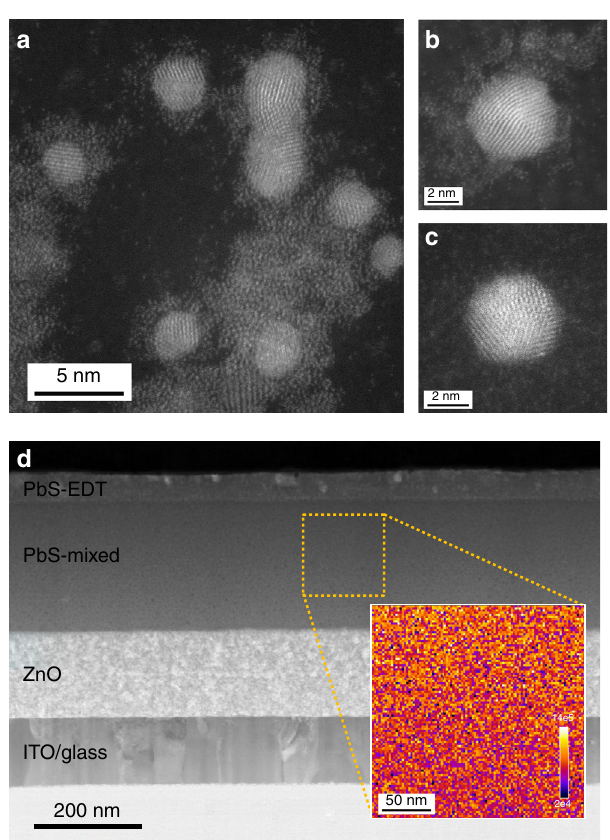
Fig. 4 Electron microscopy analysis of mixed-quantum-dot solid and device. a STEM-HAADF image of freshly drop-cast mixed-QD ink on an ultrathin graphite-based TEM grid (sample was not annealed). QDs with amorphous MAPbI 3 shell ( b ) and without surface shelling ( c ). d Cross-section STEM image of FIB-processed mixed QD-based photovoltaic device. Inset: EELS mapping of iodine in the highlighted region (200 nm by 200 nm) indicating the homogenous dispersion of MAPbI 3 -passivated QD within the mixed QD active layer (major edge of iodine M 4,5 signal starting at around 625 eV, signal intensity unit: a.u., Supplementary Fig.